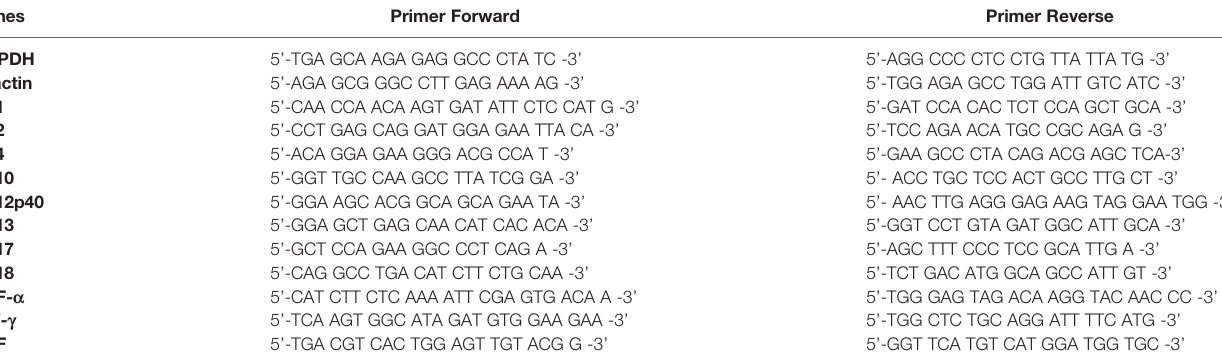
TABLE 2 | Primers used in this study for evaluating the genes expression including GAPDH, b -actin, IL-1, IL-2, IL-4, IL-10, IL-12p40, IL-13, IL-17, IL-18, TNF- a , INF- g , and TGF through an iCycler from mouse splenocytes.